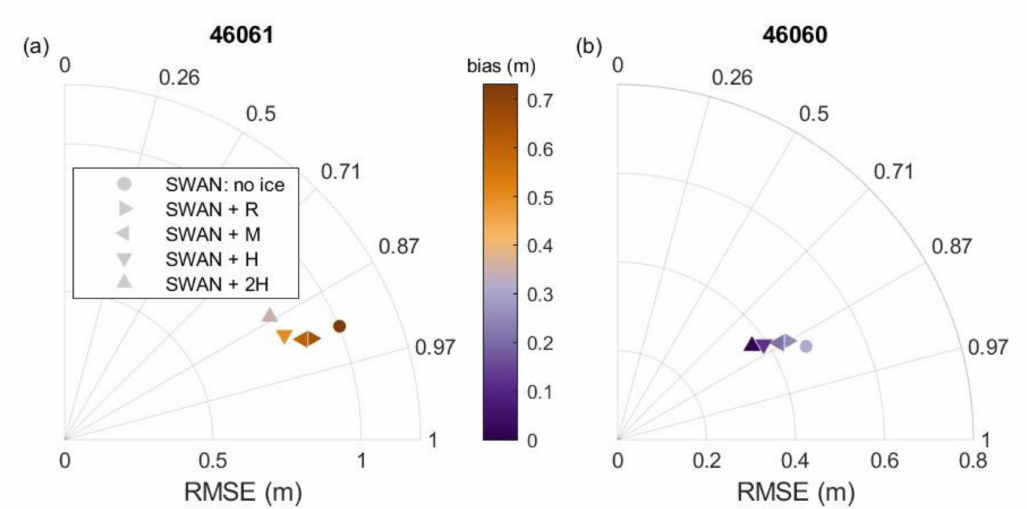
Figure 7. Root mean square error, correlation coefficient, and bias of comparisons between the SWAN model and the buoys for the month of December 2017. The RMSE is the distance from the origin, the correlation coefficient is shown as the angle from the y-axis, and the bias is shown as the color of the marker. ( a ) The comparison at buoy 46061 near the mouth of PWS; ( b ) the comparison at buoy 46060 inside PWS.